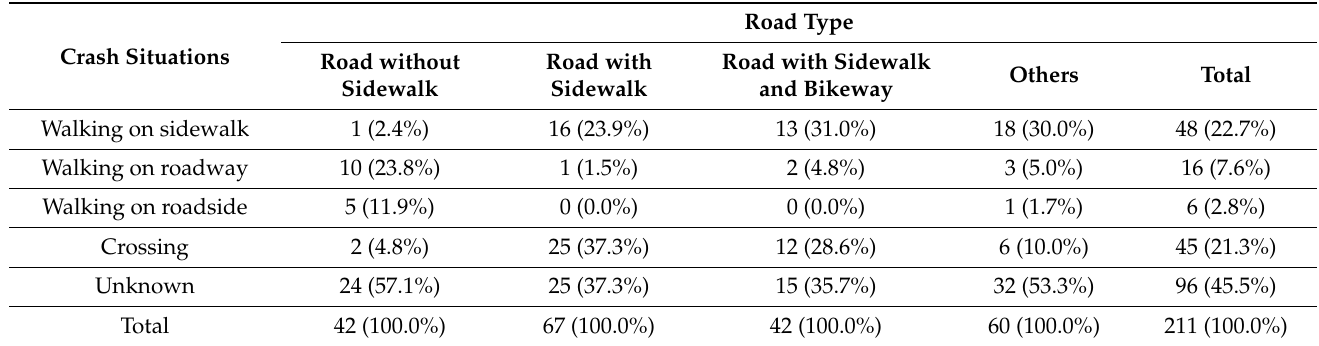
Table 6. Frequency of PM–pedestrian accidents by crash situations and road types.